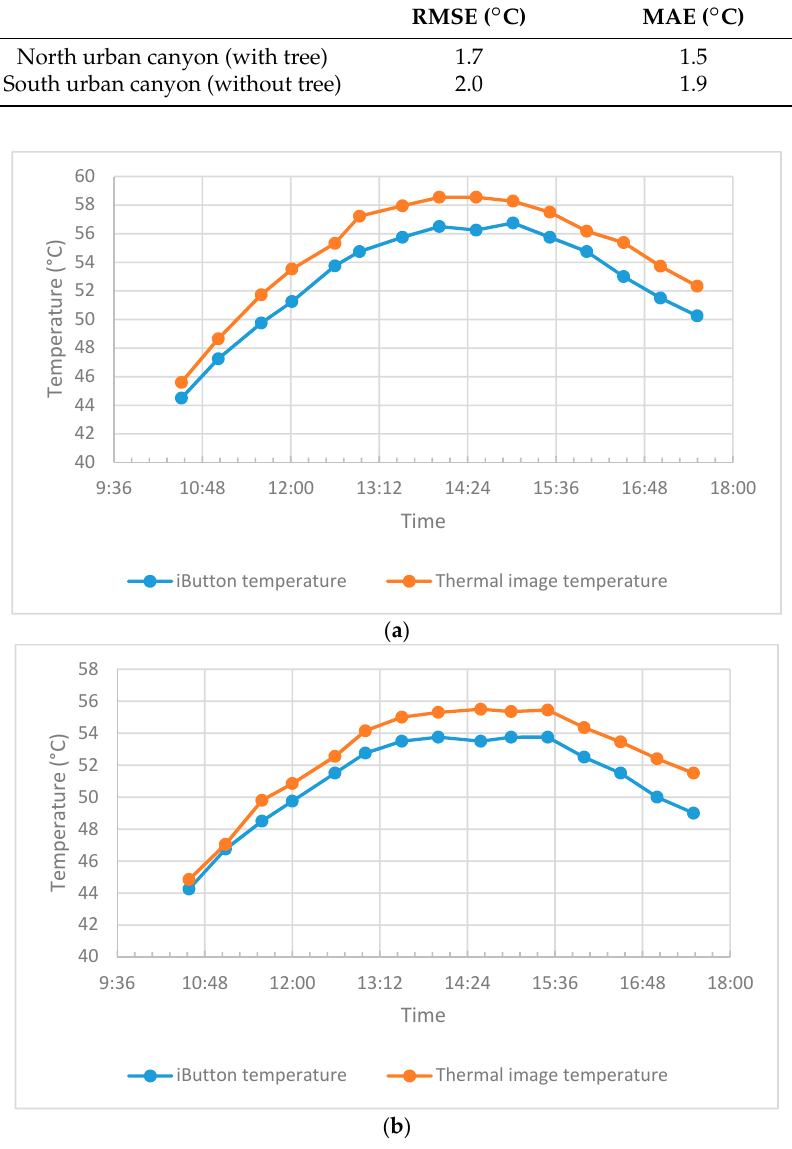
Figure 6. Temperature comparison between iButtons and thermal images of proximal exposed concrete block surfaces. ( a ) South urban canyon (without tree); ( b ) North urban canyon (with tree). Since the iButton was wrapped by white printer paper and the paper had higher reflective rate comparing to the grey concrete block surface, less direct solar radiation was received by the iButton loggers. On the other hand, the concrete blocks had higher heat capacity, and easily heated up under direct solar radiation. It was not surprising that the temperature of the calibrated iButton loggers were lower than the real concrete block surface temperature. The average systematic error (temperature differences between iButtons and thermal images) was 1.9 °C in the south urban canyon and 1.5 °C in the north urban canyon. After accounting for the temperature bias between iButton and thermal camera measurements, the measurement errors of the cooling benefits of tree shade were around 0.3 °C between two canyons, according to the RMSE. When considering the accuracy of iButton (±1 °C) and FLIR thermal camera (±2 °C or 2% of reading), the preliminary experimental results showed that iButton can be used to measure and compare the building facade surface temperature in this scale model experiment. The method used in measuring the skin temperatures was a compromise due to the practical difficulty and complexity in measuring surface temperatures using direct contact sensors such as flat surface thermistors or thermocouples.